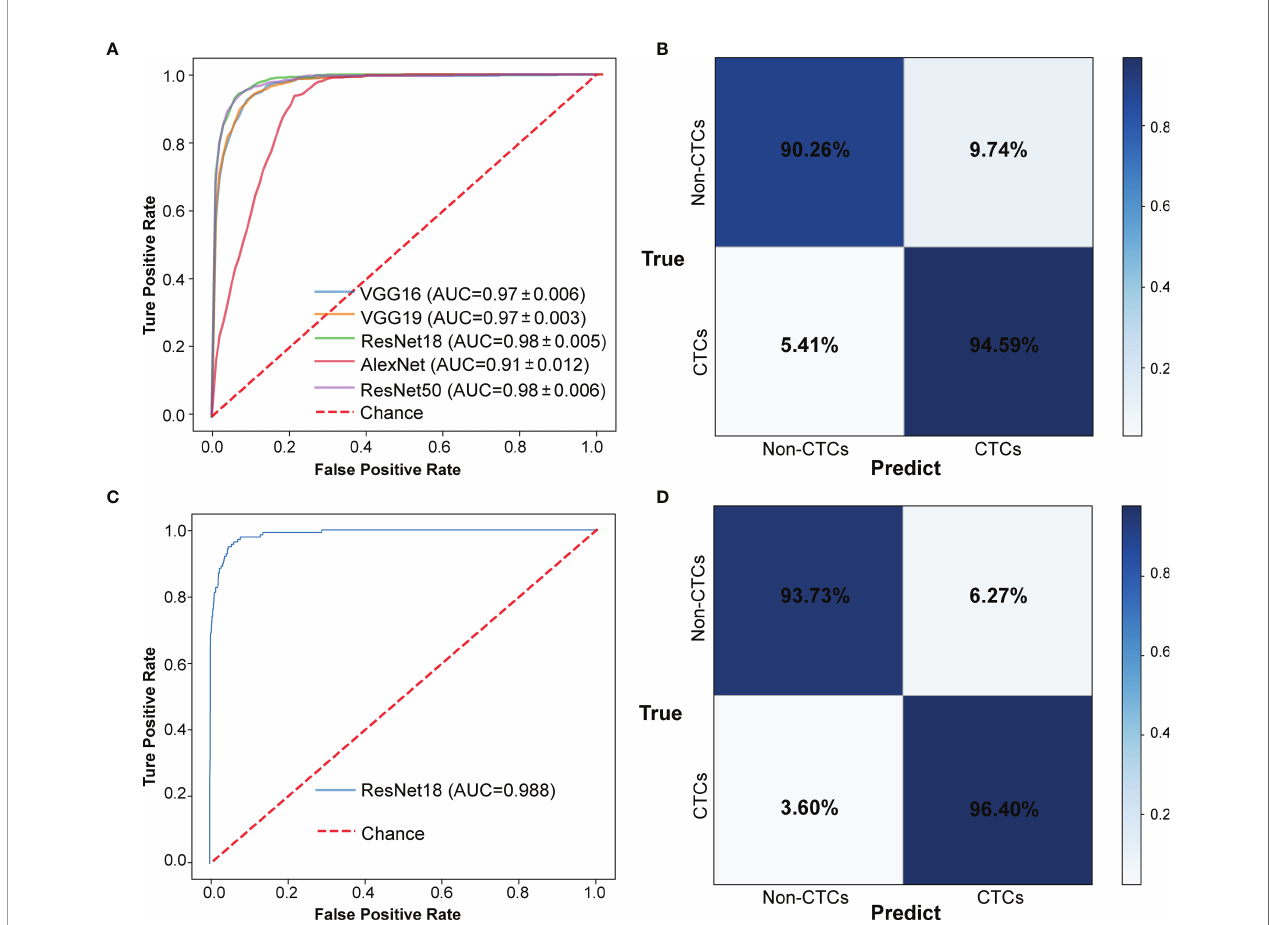
FIGURE 4 | The results of CTCs identify based on traditional CNN. (A) ROC curve of 5-fold CV in train data set. (B) Confusion matrix of 5-fold CV in train data set. (C) ROC curve in test data set. (D) Confusion matrix in test data